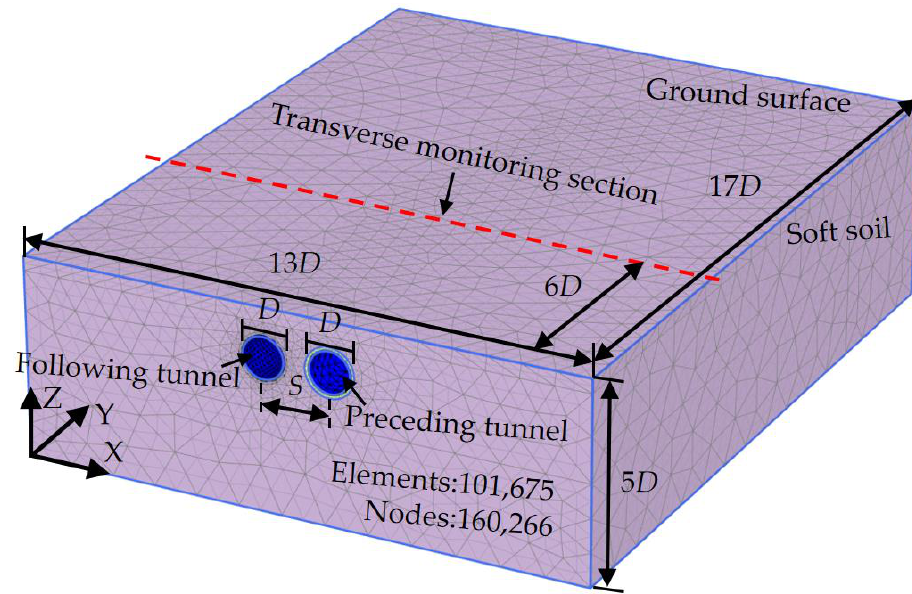
Figure 3. Finite element model for construction simulation of paralleled twin tunnels.